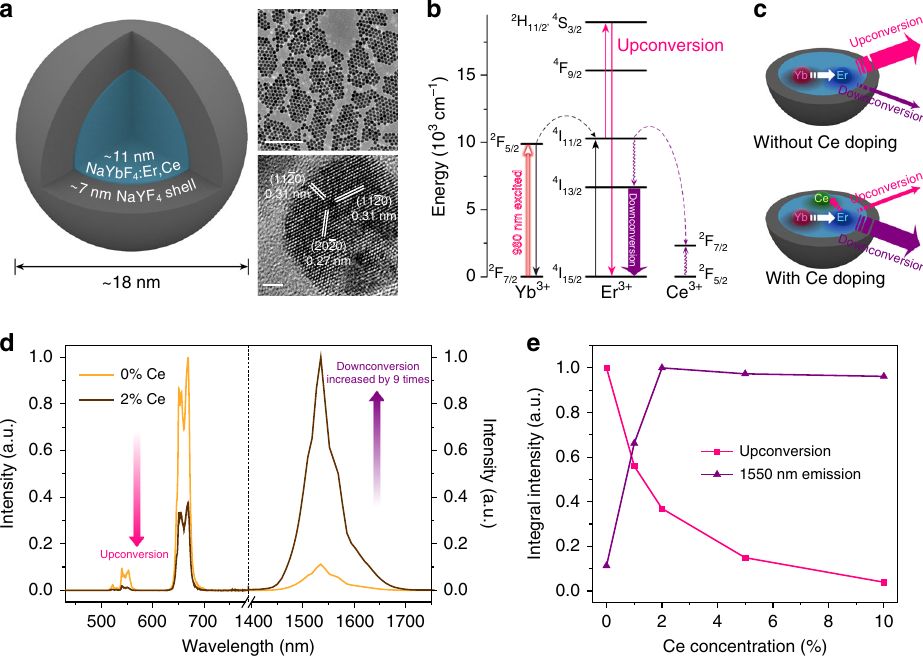
Fig. 1 Ce 3+ doped rare-earth nanoparticles with enhanced NIR-IIb luminescence. a Schematic design of a NaYbF 4 :Er,Ce@NaYF 4 core-shell nanoparticle (left) with corresponding large scale TEM image (upper right, scale bar = 200 nm) and HRTEM image (lower right, scale bar = 2 nm). b Simpli fi ed energy-level diagrams depicting the energy transfer between Yb 3+ , Er 3+ , and Ce 3+ ions. c Schematic illustration of the proposed energy-transfer mechanisms in Er-RENPs with and without Ce 3+ doping. d Upconversion and downconversion luminescence spectra of the Er-RENPs with 0 and 2% Ce 3+ doping. e Schematic representation of Ce 3+ doping concentration and corresponding upconversion and downconversion emission intensity of the Er-RENPs upon 980 nm